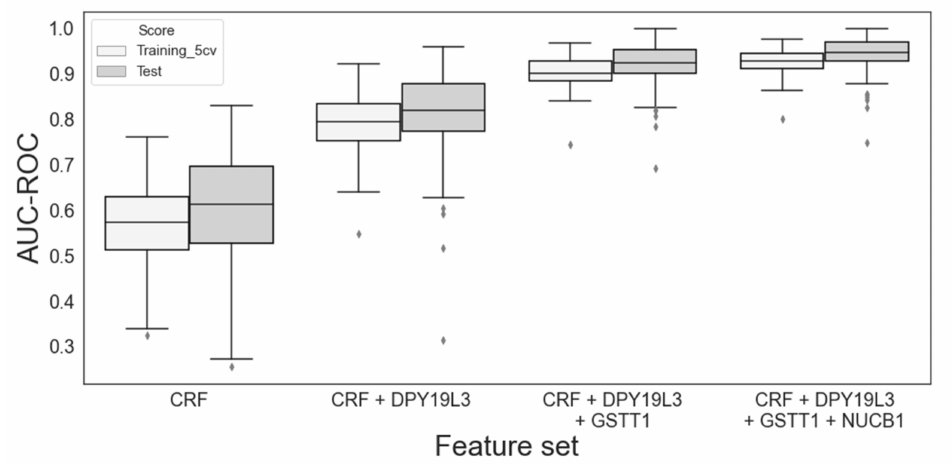
Figure 4. Performance evaluation of the models built with varying sets of features for classifying the non-durable response (NDR) vs. the durable response (DR). The feature genes were the same as listed in Table 3. A total of eight patient clinical parameters (see Methods Section), denoted as CRF in the figure, were also included in the model without further feature